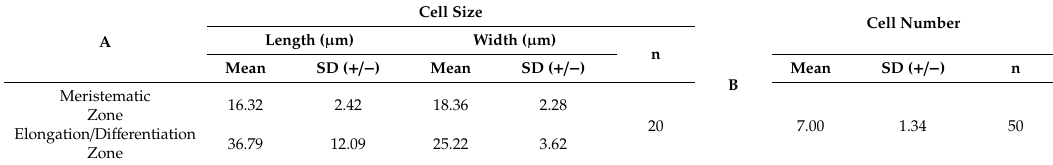
Table 1. Root zonation and meristem size determination of the first stem-borne root of Ceratopteris richardii . ( A ) The meristematic zone ends when cells begin to elongate. The change in cell elongation can be detected by measuring length of the outer cortex layer. Both measurements were assessed by using a paired student’s t test. ( B ) The Ceratopteris first stem-borne root meristem size is seven cells in average at 30